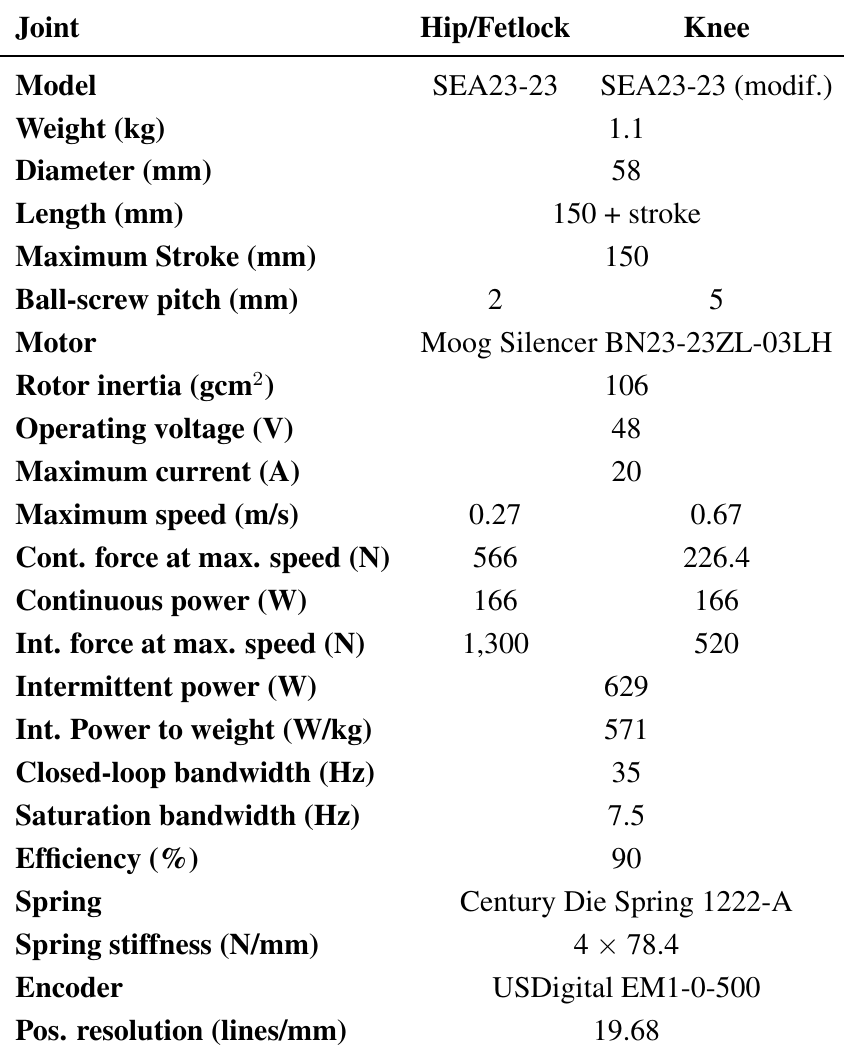
Table 8. Actuator